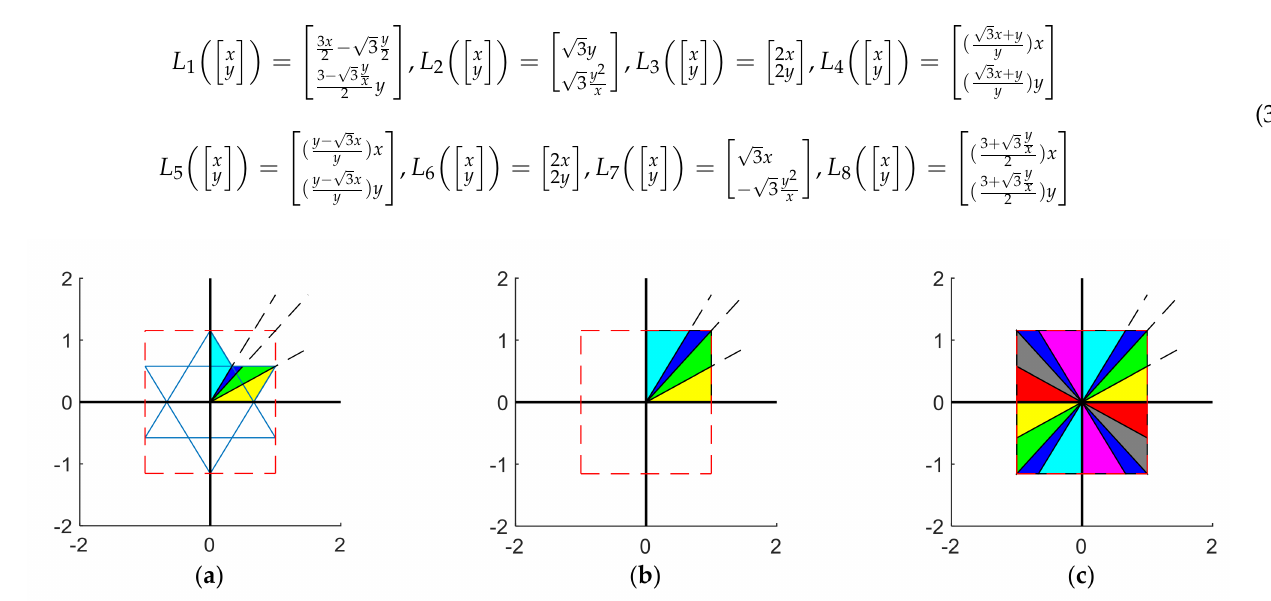
Figure 2. Mapping of hexagons into several triangles: ( a ) 1/4 hexagonal division method; ( b ) 1/4 hexag- onal mapping into small rectangles; ( c ) hexagon divided into 16 small triangles for mapping. The hexagon is an axisymmetric figure, so the mapping function of L 9-16 , which is the same as L 1-8 , is not